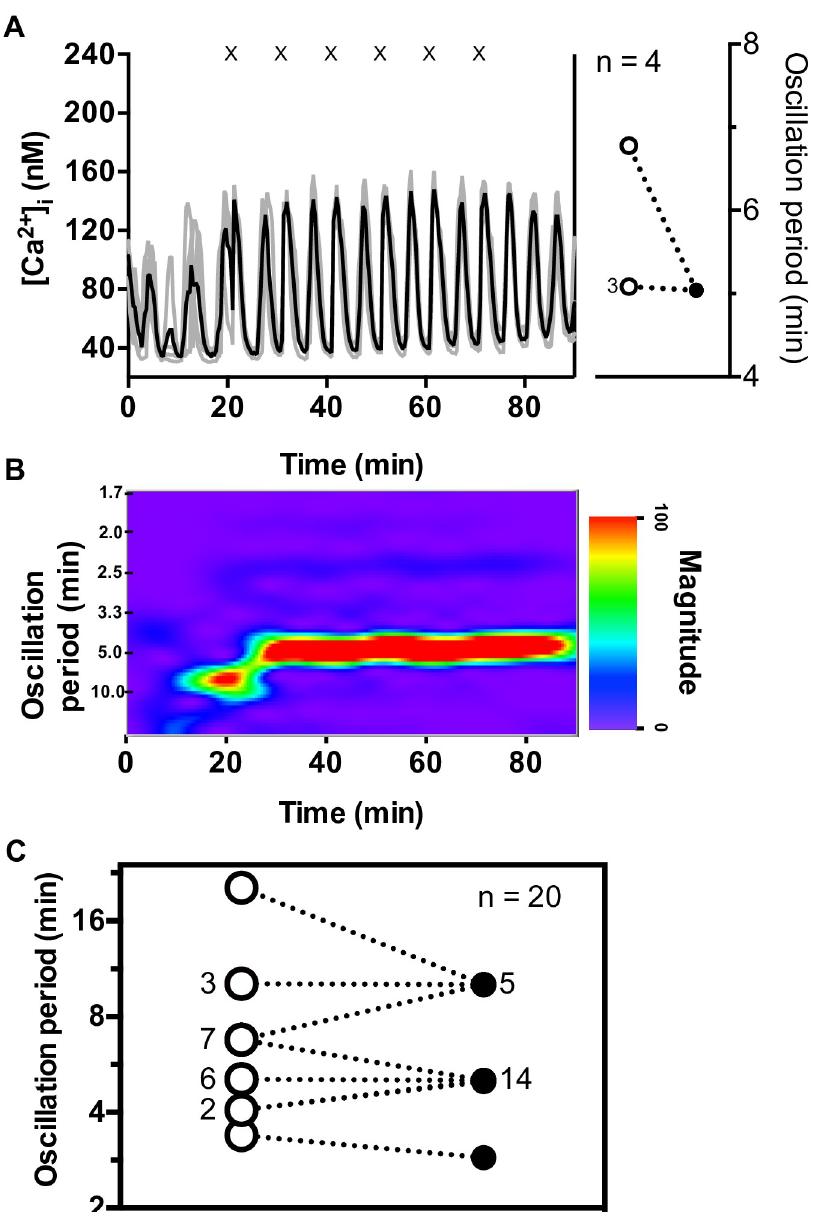
Fig 4. Effect of CCh pulses with rest time of R = 10 min on [Ca 2+ ] i oscillations. (A) In this example, all four islets had a natural period, as seen in the inset, between 5.1–6.8 min (open circles) which entrained to 5 min (1:2) during the pulsing period (filled circle). The number of islets with identical oscillation periods before or during pulsing is indicated adjacent to the relevant circle. (B) The synchronized response of the group is evident by the emergence of a pronounced band at 5 min during the CCh pulsing. After the final pulse, 5 min oscillations persisted until the end of the Ca 2+ measurement. See S10–S13Figs for results from the remaining R = 10 min groups. (C) A compilation of the oscillation periods of all 20 islets tested prior to (open circles) and during pulsing (filled circle) with R = 10 min is